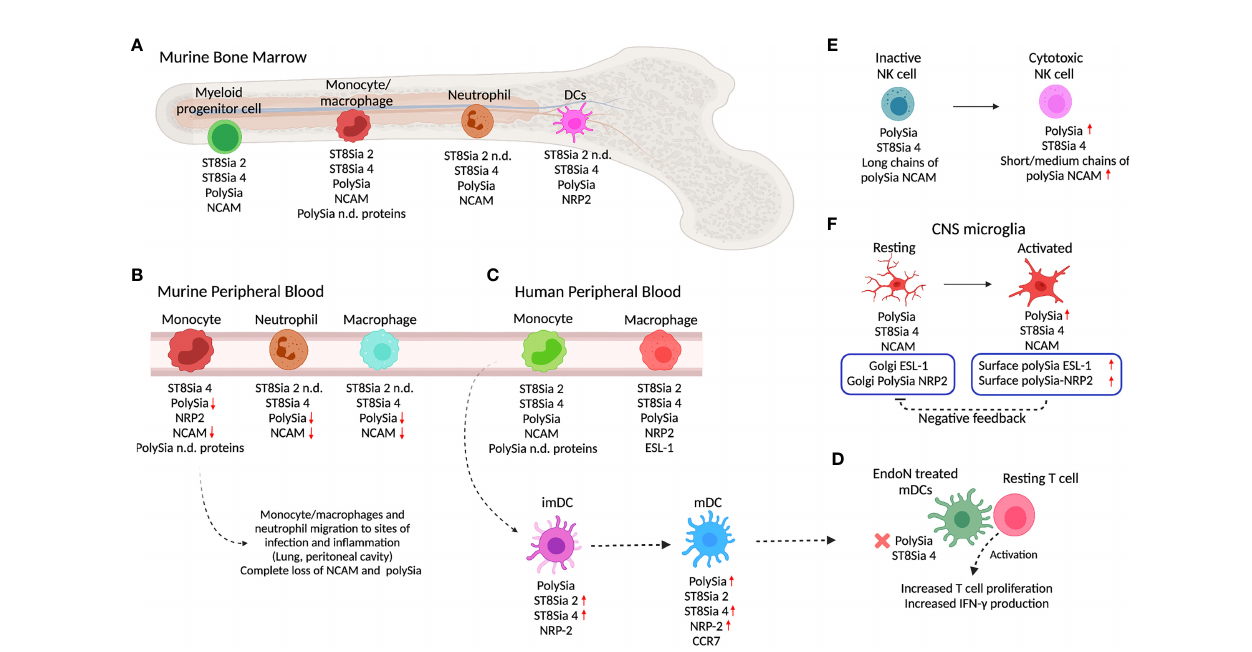
FIGURE 2 | PolySia and polyST expression in innate immune cells. (A) In the murine bone marrow (BM), different myeloid progenitor cells, monocytes/macrophages, neutrophils, and DC express polySia, ST8Sia 2, ST8Sia 4, NRP2, NCAM, or non-identi fi ed polySia proteins. (B) As they migrate into the peripheral blood, murine BM- derived monocytes/macrophages and neutrophils lose polySia-NCAM. As the macrophages and neutrophils arrive at infection or in fl ammation sites, polySia is depleted from the cell surface. (C) In the periphery, human macrophages and monocyte-derived cells express polySia and polySia carriers such as NRP2, NCAM, ESL-1, and unknown proteins. Once monocytes differentiate into imDC, they express polySia-NRP2 which in turn is upregulated during maturation to mDC. (D) Depletion of polySia by using EndoN neuraminidase in mDCs promotes increased T cell activation. (E) NK cells overexpress polySia and ST8Sia 4 during differentiation into cytotoxic cells. Chain length differentiates between non-cytotoxic and cytotoxic NK cells. (D) The depletion of polySia in mDC by using EndoN induces better activation and increased proliferation of T cells, suggesting a role of polySia in regulation of T cell activation. (F) In the innate immunity of the CNS, microglia cells also express polySia. The increase in polySia-NRP2 expression in the surface of microglia cells induces negative feedback on Golgi polySia-NRP2 localization and expression. The increase or decrease of polySia expression with respect to the precursor state is indicated with red arrows (up or down, respectively). Created with